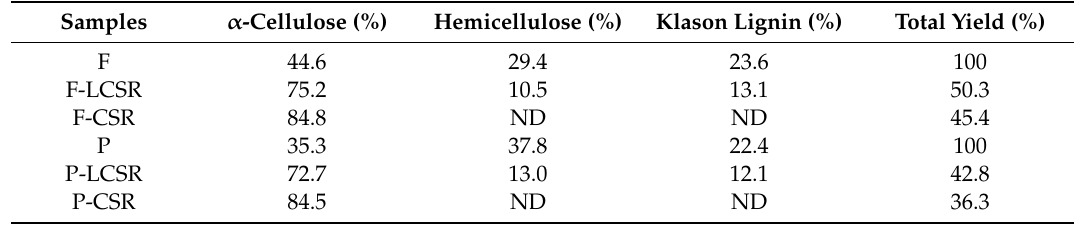
Table 2. Comparison of the yield and chemical composition between fibers and parenchyma cells from